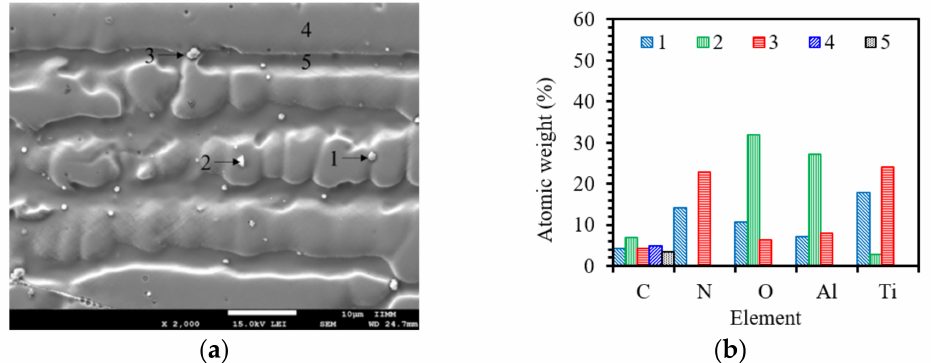
Figure 6. ( a ) The SEM image at the weld metal with the ER310 filler and ( b ) the results of the EDX dot chemical compositions of the points indicated in ( a